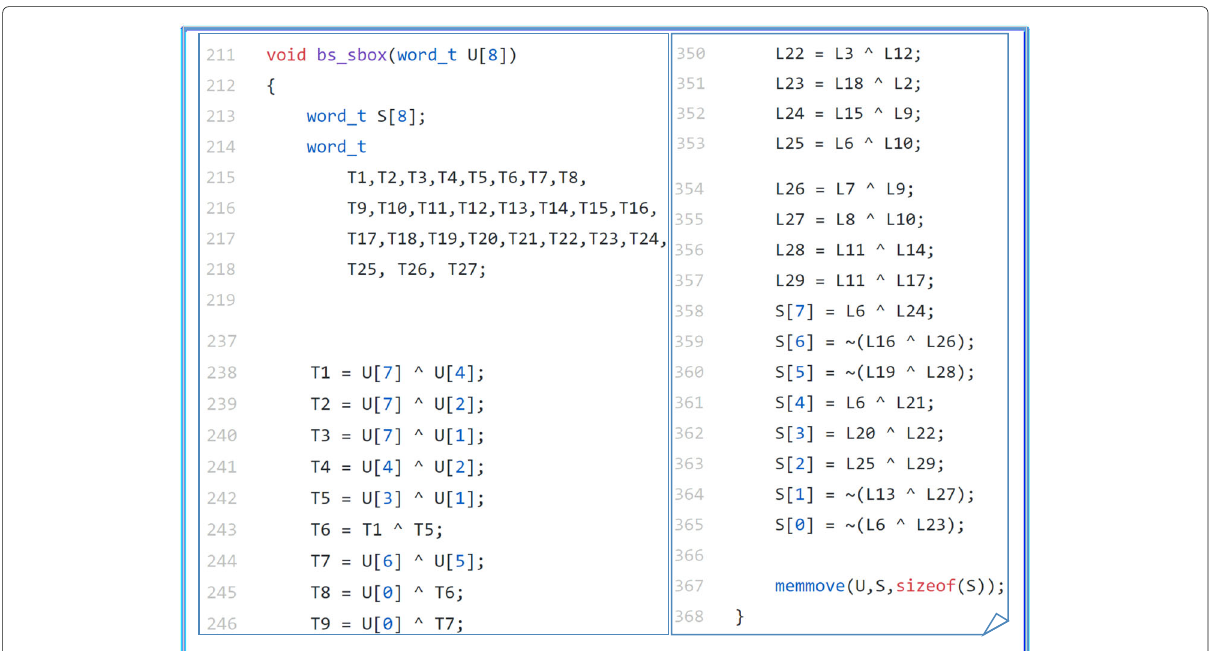
Fig. 4 The C code snippet of the SubBytes of a bitsliced